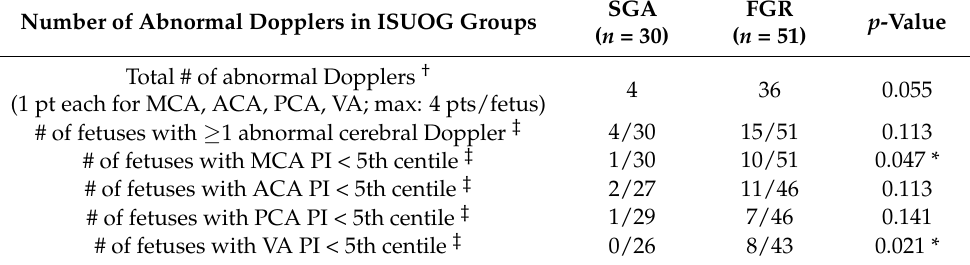
Table 3. Comparison of cerebral Dopplers in FGR and SGA cohorts. Number of Abnormal Dopplers in ISUOG